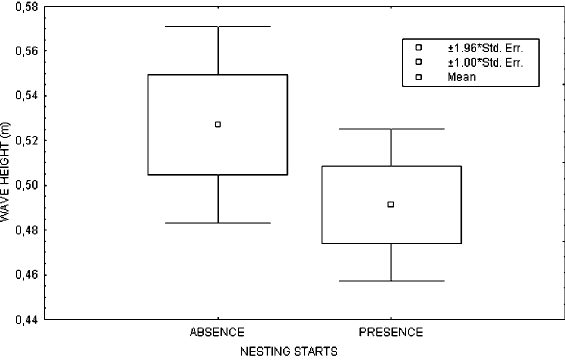
F IG . 2. – Plot of means and standard errors of wave height on both the day before and the same day of the sampling, compared for days with presence/absence of nesting starts (stage 1 nests, n=sampling